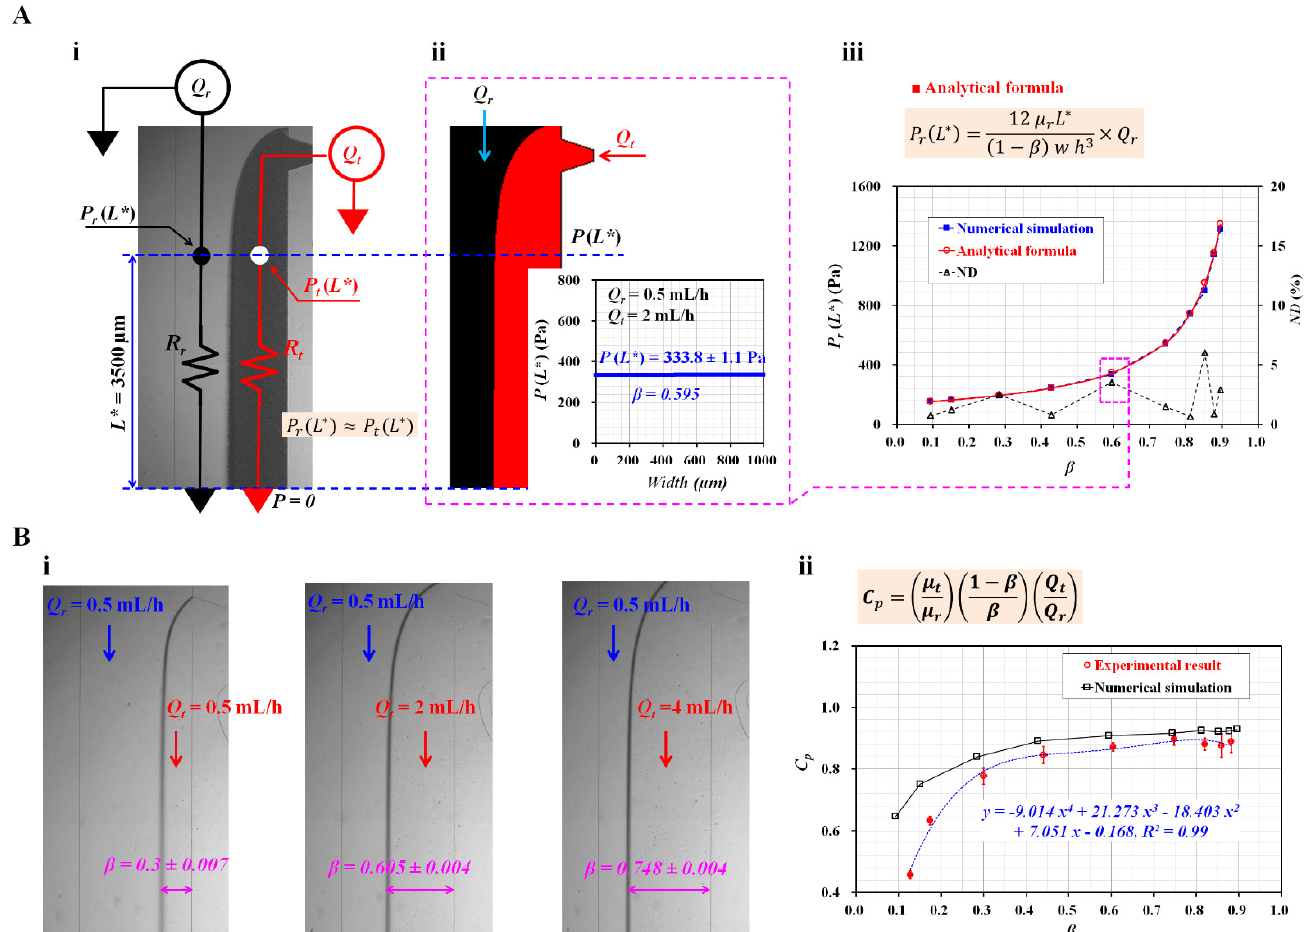
Figure 2. Validation of junction pressure and correction factor in the coflowing channel. ( A ) Comparison of junction pressures obtained using numerical simulation and analytical formula. ( A - i ) Discrete fluidic circuit model of the two fluids flowing in the coflowing channel. ( A - ii ) Pressure estimation through numerical simulation. The junction pressure and interface obtained were P ( L* = 3500 µm ) = 333.8 ± 1.1 Pa and β = 0.595. ( A - iii ) Variations in P r ( L* ) obtained using numerical simulation and analytical formula with respect to β . ( B ) Calculation of correction factor ( C P ) with respect to the interface. ( B - i ) Microscopic images showing variations in the interface with respect to the flow rate of test fluid ( Q t ) ( Q t = 0.5, 2, and 4 mL/h). ( B - ii ) Variations in C P obtained from numerical simulations and experiments with respect to β . Based on the variations in β obtained from the experiments, the regression analysis resulted in a correction factor C p = − 9.014 β 4 + 21.273 β 3 − 18.403 β 2 + 7.051 β − 0.168 ( R 2 = 0.99).